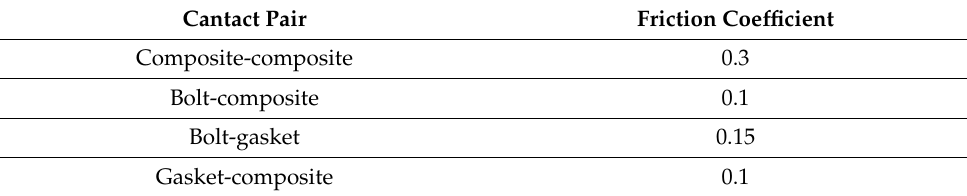
Table 3. Friction coefficient of each contact